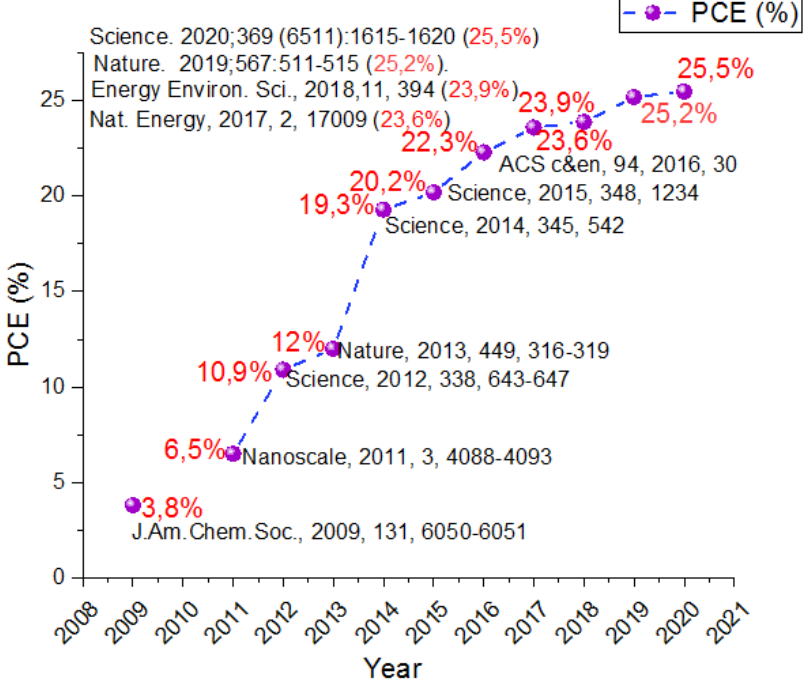
Figure 2 . The best annual yield of solar cells based on